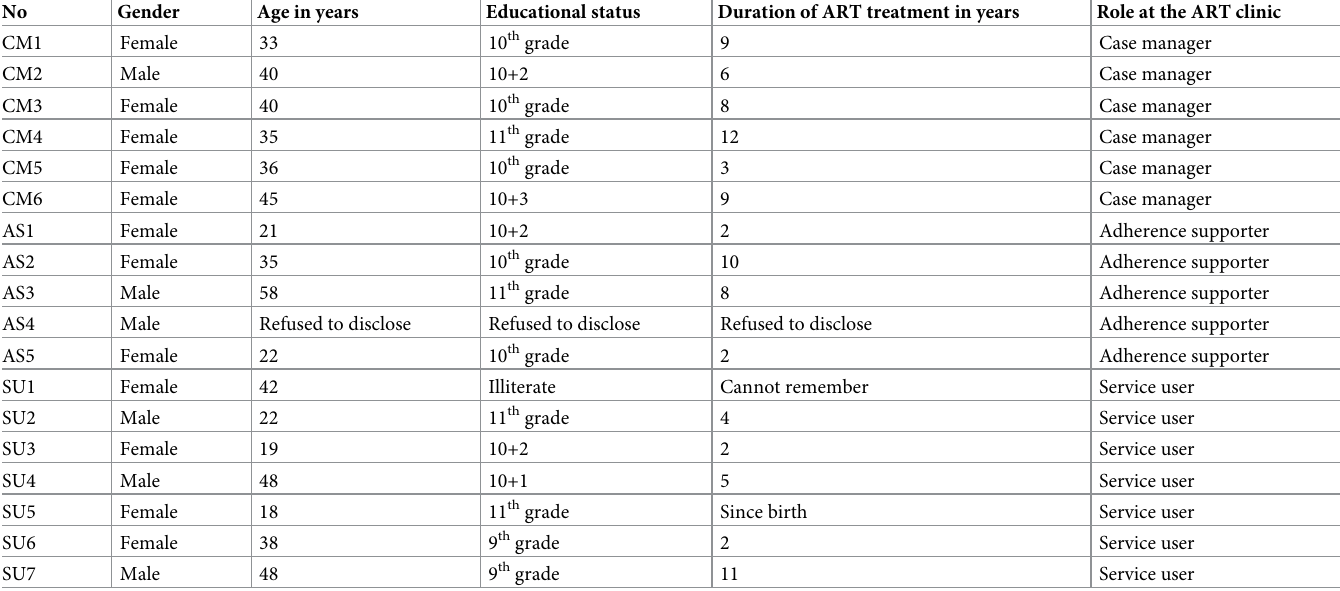
Table 1. Sociodemographic characteristics of focus group participants, N = 18.